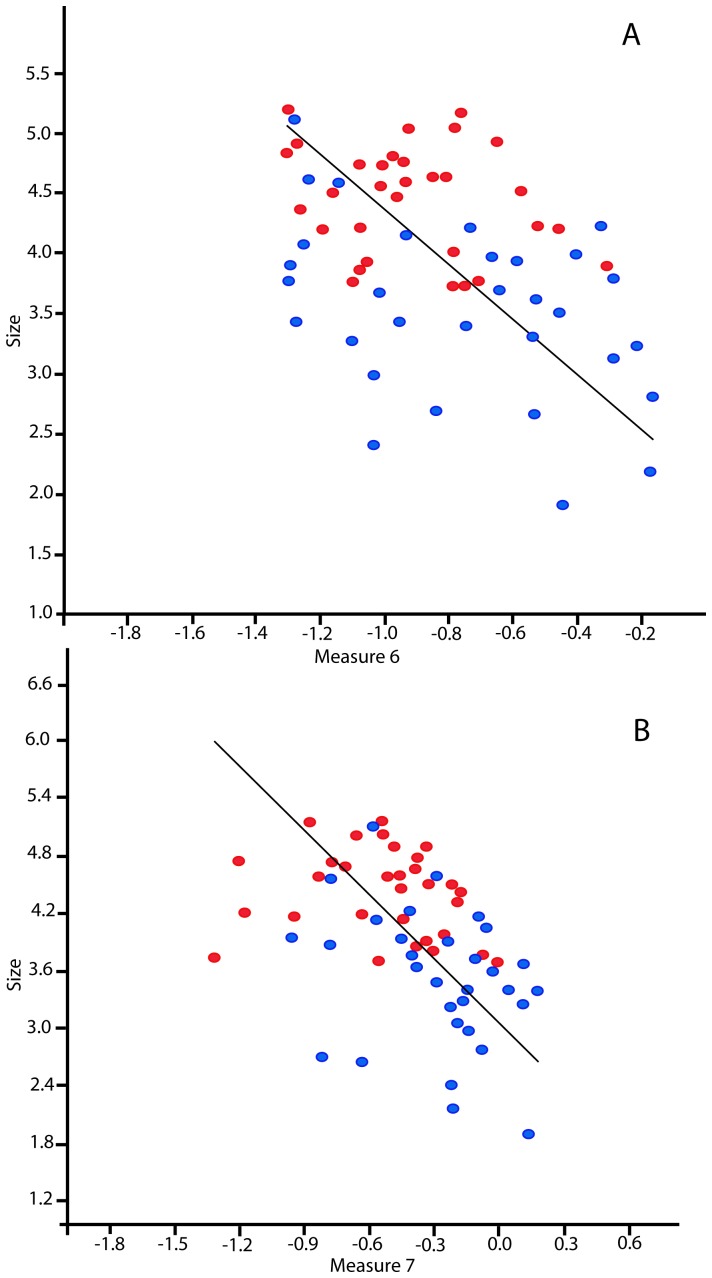
Relationships between two measures of cutmark shape and cut-mark size.(A) Regression of logged measure 6 against log size for all the cut-marks measured. Blue dots refer to aquatic modifications. Red dots refer to terrestrial modifications. (B) Regression of logged measure 7 against log size for all the cut-marks measured. Blue dots refer to aquatic modifications. Red dots represent terrestrial modifications.